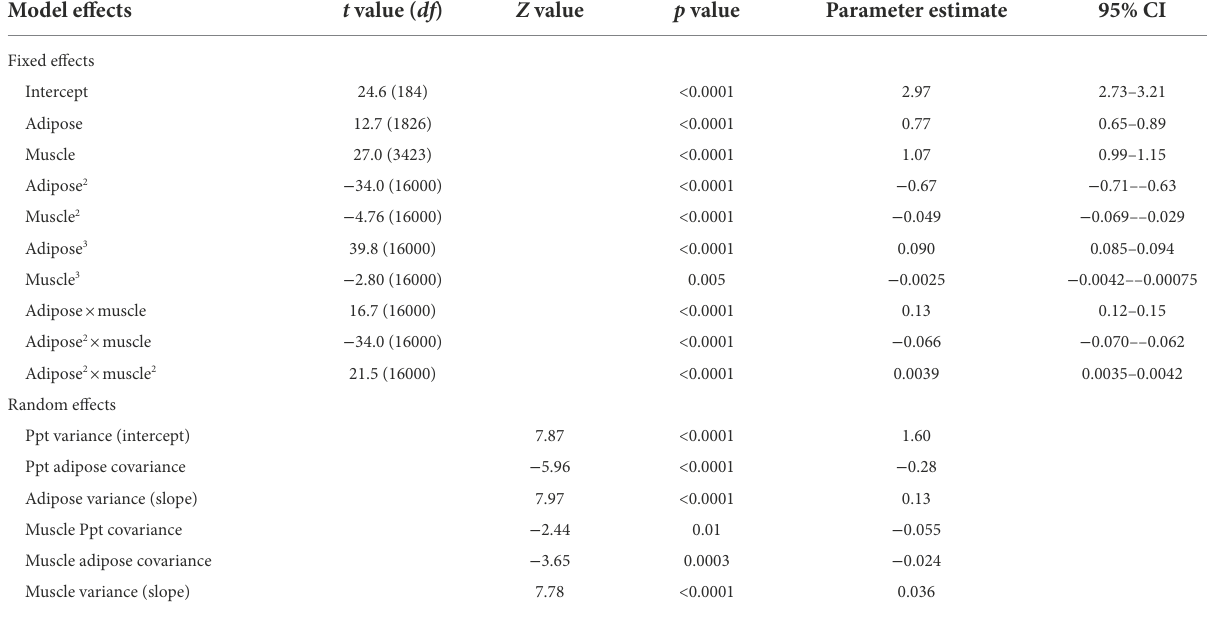
TABLE 3 Linear mixed effects model of responses to images of